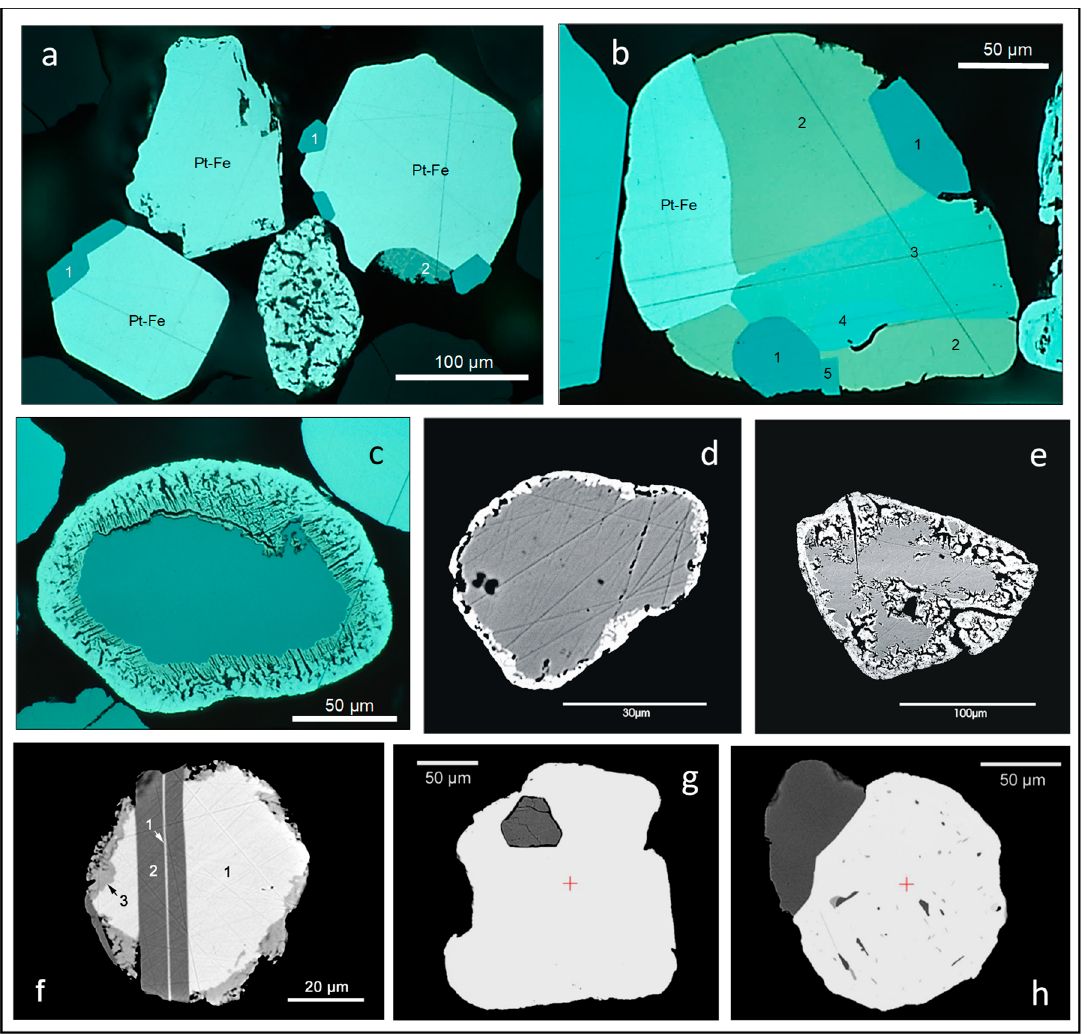
Figure 6. Detrital PGM in polished sections. Reflected light, oil immersion ( a – c ), and BSE images ( d – h ). ( a ) Three grains of Pt–Fe alloy (Pt–Fe), with attached laurite (1) and RhFeNi sulfide (2). Porous grain (lower half, center) is native platinum. Maandagshoek. ( b ) Composite grain consisting of Pt–Fe alloy, laurite (1), törnroosite [Pd 11 As 2 Te 2 ] (2), palladoarsenide [Pd 2 As] (3), sperrylite (4), and irarsite (5). Maandagshoek. ( c ) Alteration of cooperate-braggite, replaced by platinum. Note intruding channels and outer, compact rim. Maandagshoek. ( d ) Sperrylite grain with rim of pure Pt. Umtshingwe River, Great Dyke. ( e ) Strongly corroded cooperite grain being replaced by pure Pt (white). Umtebekwe River, Great Dyke. ( f ) Polyphase grain of Pt–Fe alloy (1) with a lamellar Ru 70 alloy (2), overgrown by a rim of [Ni 2 PtFe] (3). Maandagshoek. ( g ) Grain of Pt–Fe alloy (white) with idiomorphic inclusion of laurite. Umsweswe River, Great Dyke. ( h ) Well-rounded grain of Pt–Fe alloy (white) with numerous inclusions of various PGM (palladodymite (Pd,Rh) 2 As, unnamed RhS, unnamed Pd 3 Te), intergrown with unnamed Rh(Ni,Cu) 2 S 3 (dark grey; top left). Umsweswe River, Great Dyke.